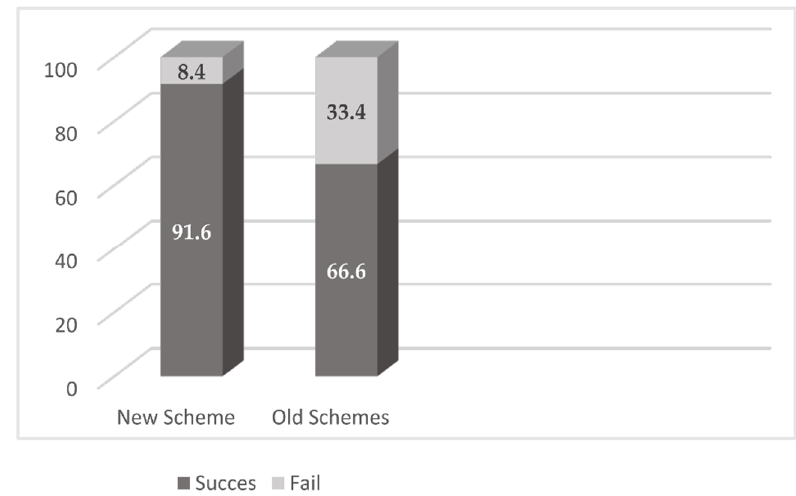
Figure 2. Percentage of clinical cure.